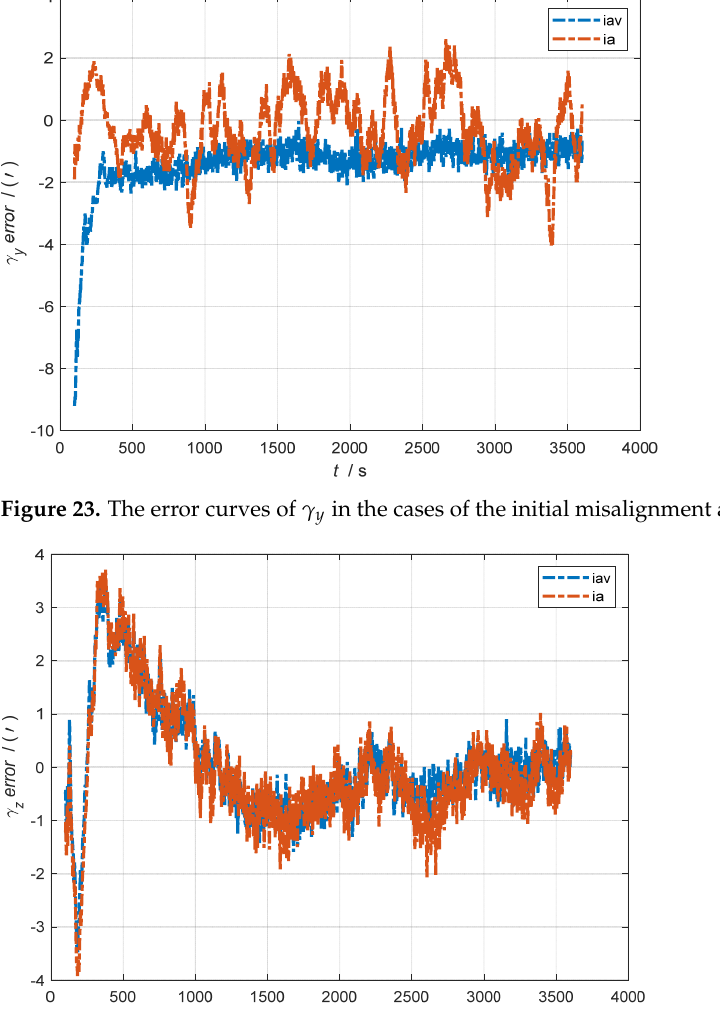
γ Figure 24. The error curves of z in the cases of the initial misalignment angles T [5 5 20 ] ° ° ° . Figure 24. The error curves of γ z in the cases of the initial misalignment angles [ 5 ◦ 5 ◦ 20 ◦ ] T